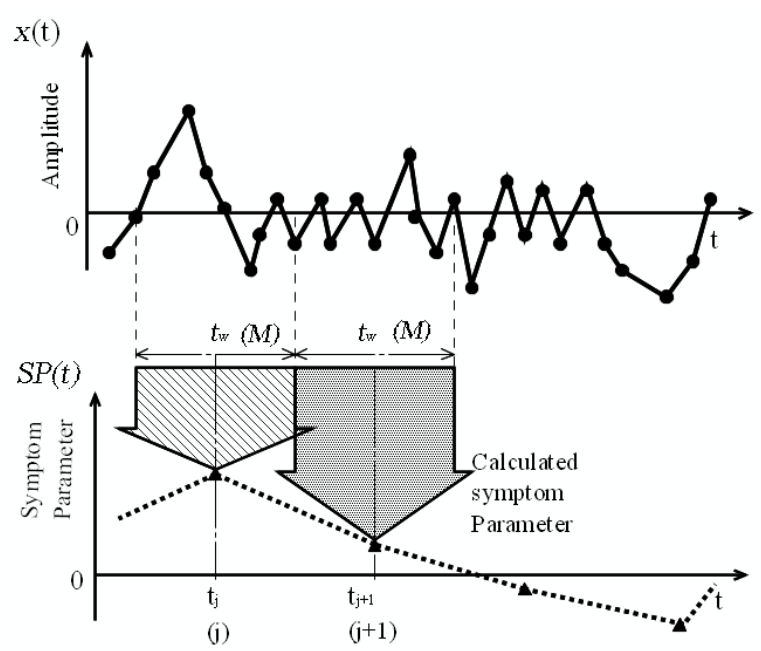
Figure 3. The method to obtain the symptom parameter